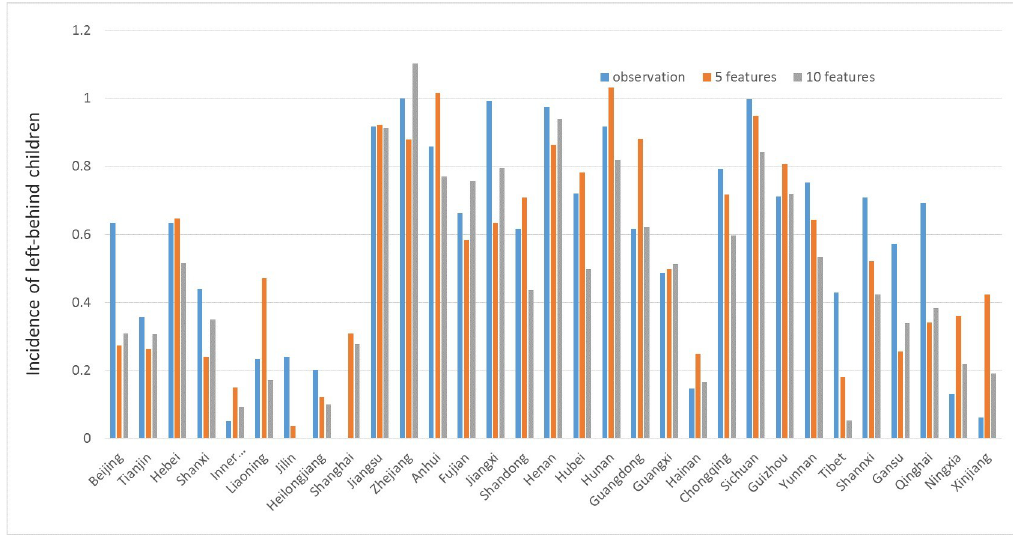
Fig 5. Prediction results for SVR models by filter method.